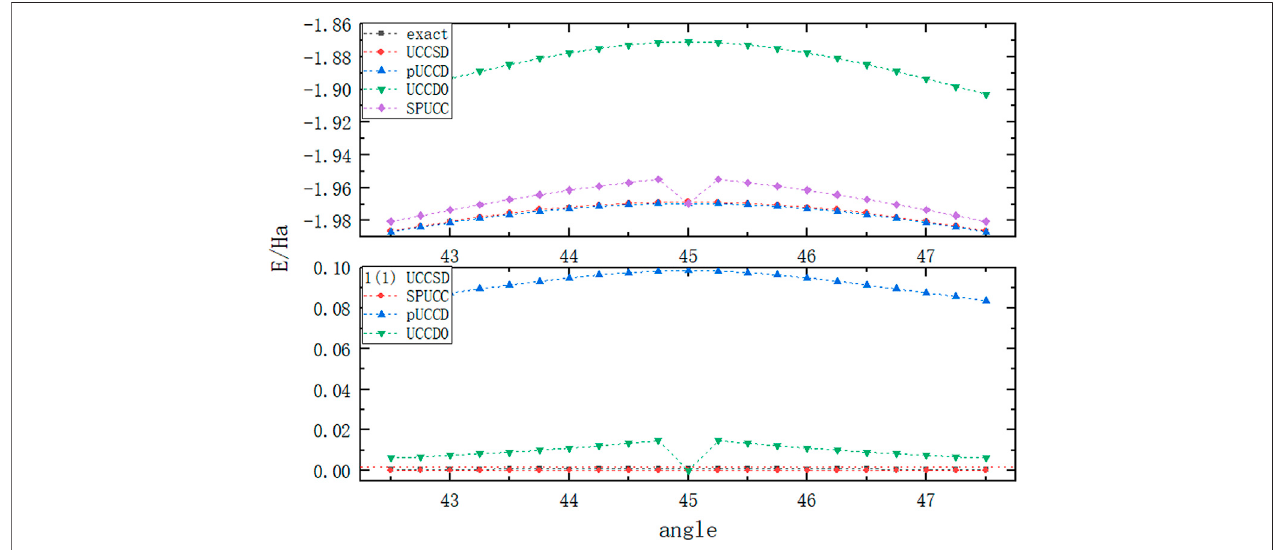
FIGURE 1 | The picture above shows the variation of the energy of H 4 molecule with the circumferential angle, and the fi gure below shows the difference of the energy of different methods and exact diagonalization from different angles. The red dotted line represents the chemical accuracy of 1 . 6 × 10 − 3 Ha .